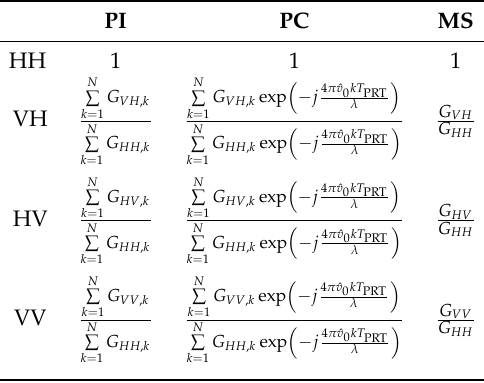
Table 2. Methods for PSM